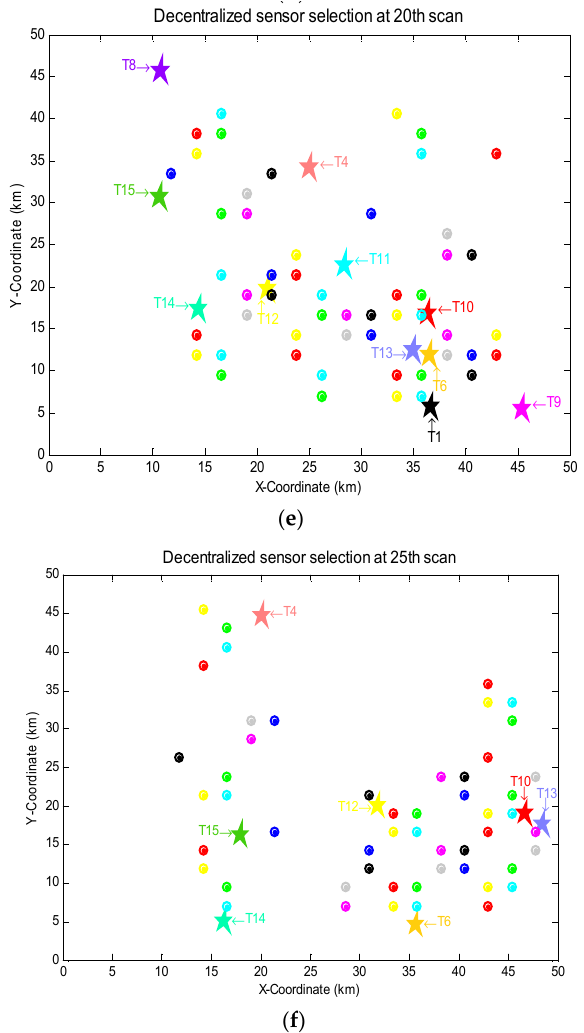
Figure 4. Sensor selection using LA bound with coordinate descend at ( a ) the 1st scan; ( b ) the 5th scan; ( c ) the 10th scan; ( d ) the 15th scan; ( e ) the 20th scan; ( f ) the 25th scan. ★ and ☉ denote the targets and selected SNs, different colors correspond to different targets and SNs of different LFCs.